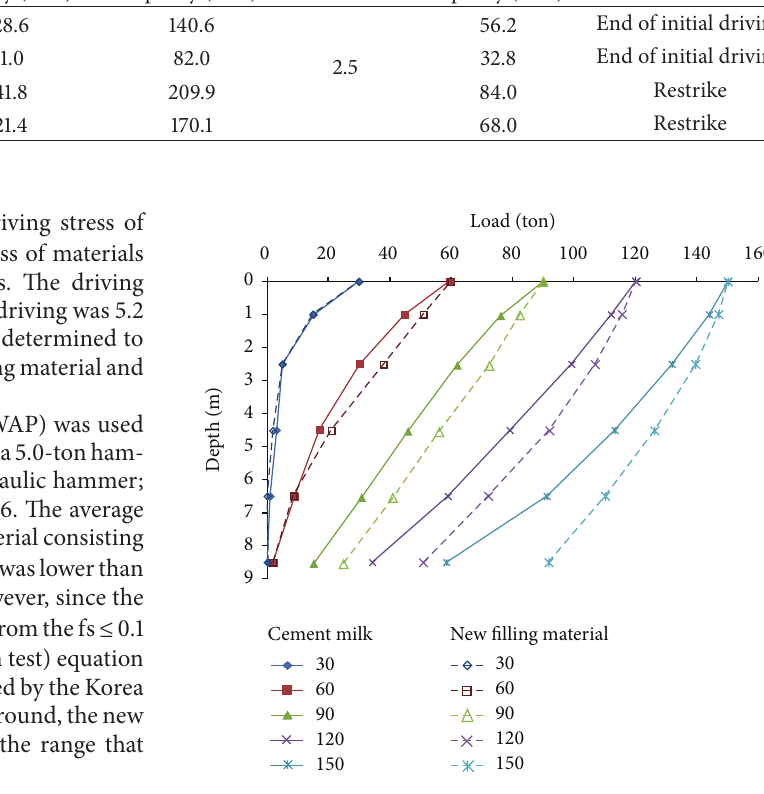
Figure 7: Axial load distributions according to